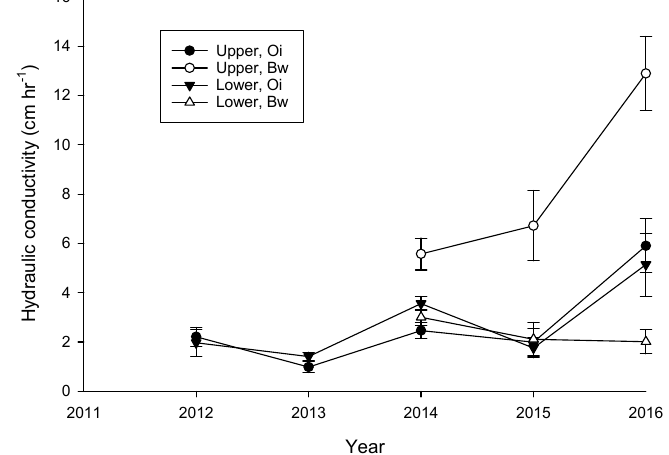
Figure 5. Infiltration for organic, mineral soil layers in each of upper and lower rain gardens at St. Francis Apartments (Cincinnati OH), 2012–2016. For reference, the infiltration rate of surrounding turf areas is 0.6 ± 0.1 cm h − 1 .